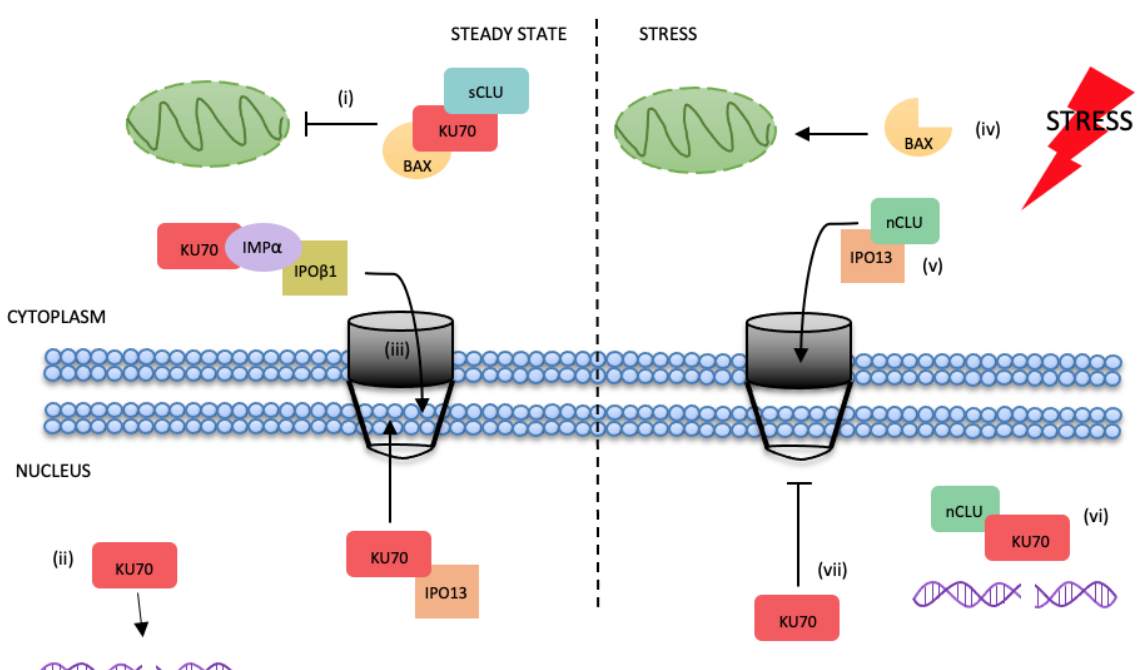
Figure 7. Model of IPO13s contribution to the DNA repair/Apoptosis decision axis as regulated by KU70 and CLU isoforms. ( i ) Under steady state conditions in the cytoplasm, KU70 sequesters Bax from the mitochondrion to prevent its activation of apoptosis. sCLU further stabilises the KU70/Bax binding and, thus, contributes to inhibition of Bax-mediated apoptosis. ( ii ) In the nucleus, KU70 senses DNA double-strand breaks (DSB), recruiting non-homologous end-joining (NHEJ) DNA repair machinery to sites of DSBs, resulting in damage repair. ( iii ) Nucleocytoplasmic transport facilitates KU7 0′ s separate roles in the cell. KU70 nuclear import is facilitated by the IMP α/IPOβ1 heterodimer. The export of KU70 is facilitated by IPO13. ( iv ) In response to cellular stress, Bax is liberated from Ku70 and presumably CLU can then initiate apoptosis. ( v ) nCLU is newly expressed under these conditions and undergoes import into the nucleus by an IPO13-facilitated pathway. ( vi ) In the nucleus, nCLU binds to KU70. Under these conditions, KU70 binding to DNA is significantly reduced and ( vii ) KU70 export by IPO13 is inhibited, which both contribute to activation of Bax and shut down of DNA repair in preparation of apoptosis.